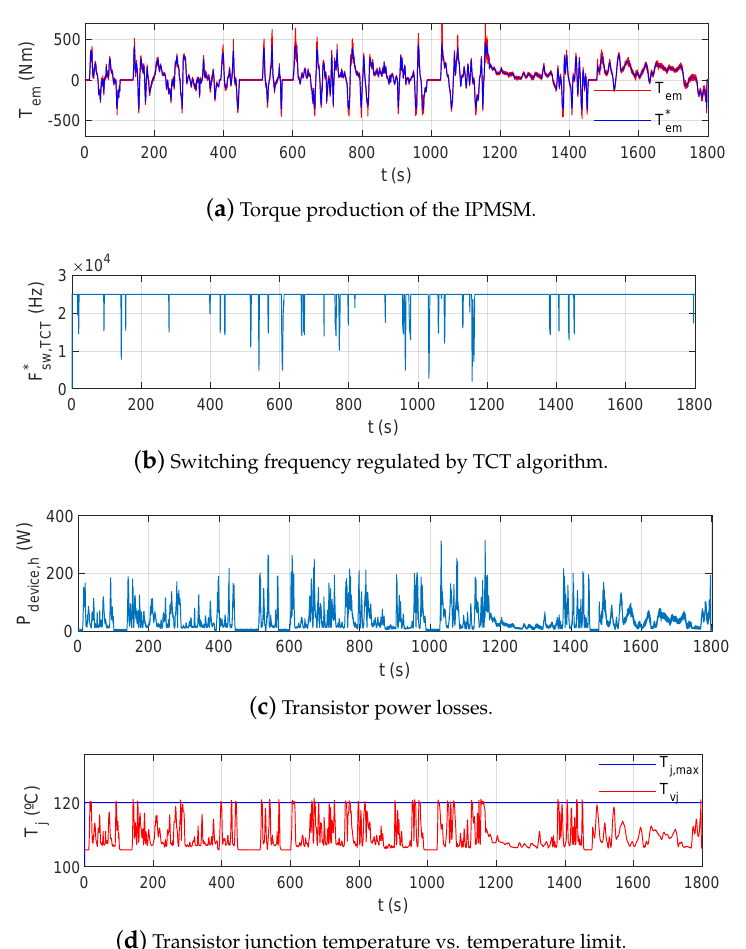
Figure 9. Simulation results of the SiC based IPMSM drive under standardized WLTP driving cycle when using TCT